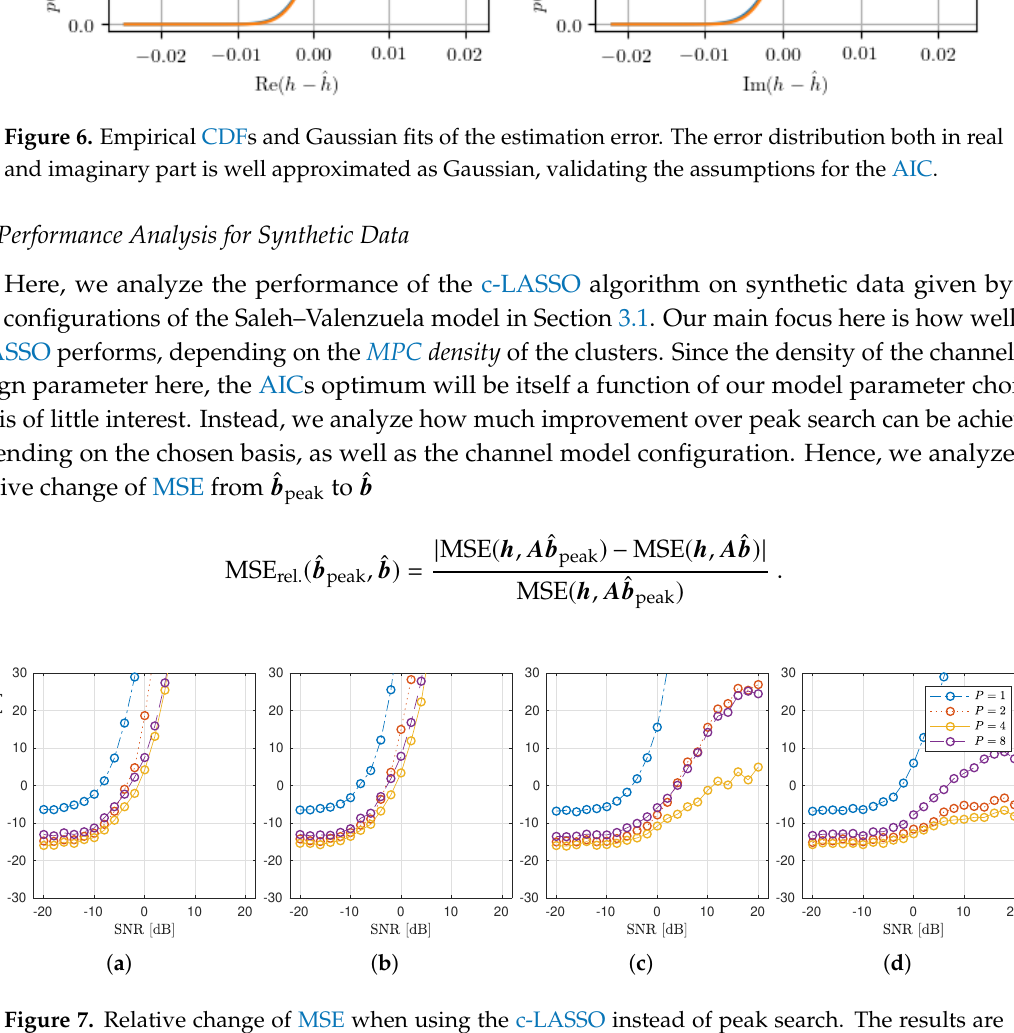
Figure 7. Relative change of MSE when using the c-LASSO instead of peak search. The results are shown for the four configurations ( a – d ) of the Saleh–Valenzuela models. The key takeaways are: (1) using P = 4 shows the overall best performance across the MSE range; and (2) for very densely populated clusters, the c-LASSO noticeably outperforms peak search across a wide range of SNR (Scenarios ( c ) and especially ( d